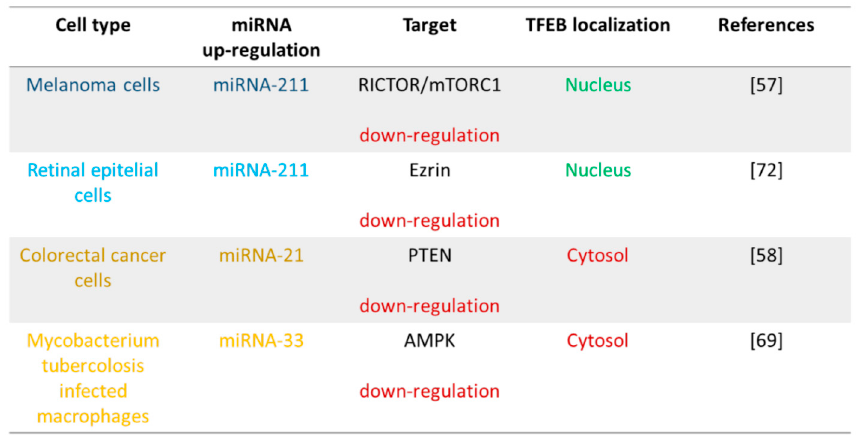
Figure 5. Regulation of TFEB activation by